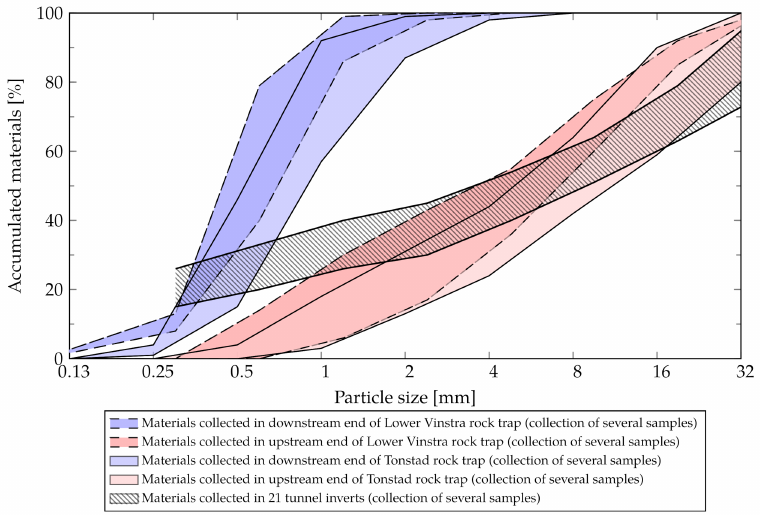
Figure 2. Particle size curve for materials in 21 tunnel inverts (gray area) (adapted from [19]), the rock trap in Lower Vinstra (adapted from [23]) and the rock trap in